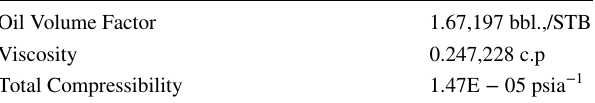
Table 7 Obtained data from buildup pressure test analysis after acidizing operation (main model parameters)